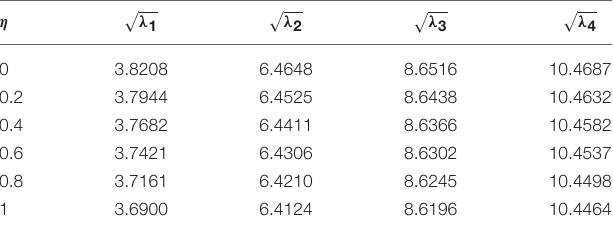
TABLE 18 | Frequency parameters parameters.